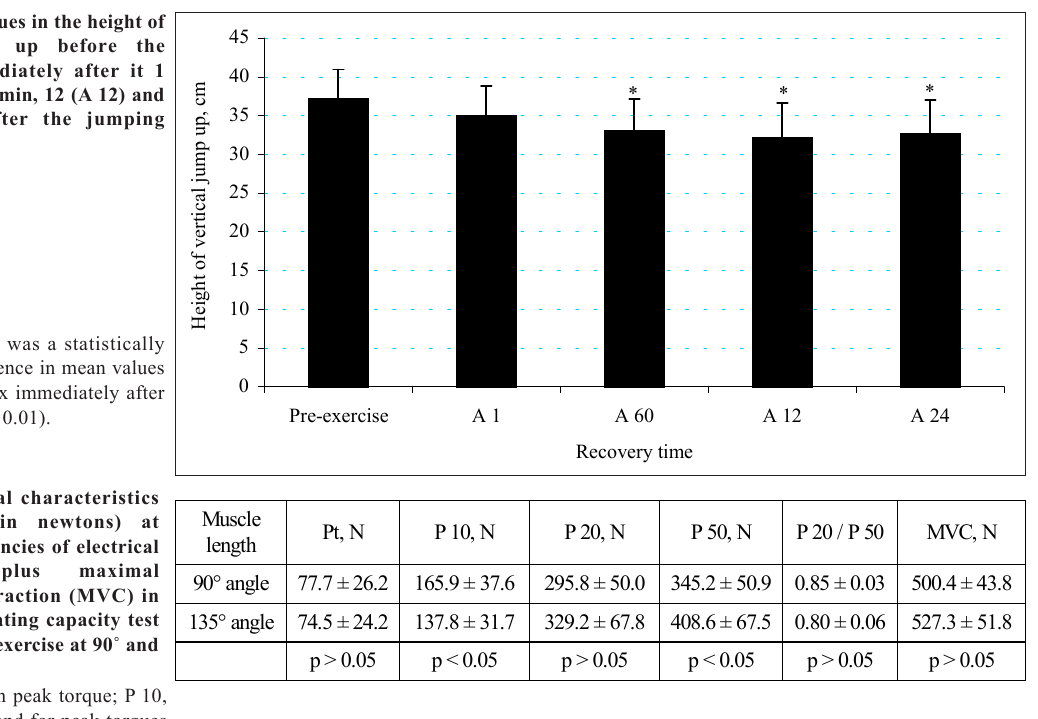
Fig. 1. Mean values in the height of vertical jump up before the exercise, immediately after it 1 (A 1), 60 (A 60) min, 12 (A 12) and 24 (A 24) h after the jumping exercise